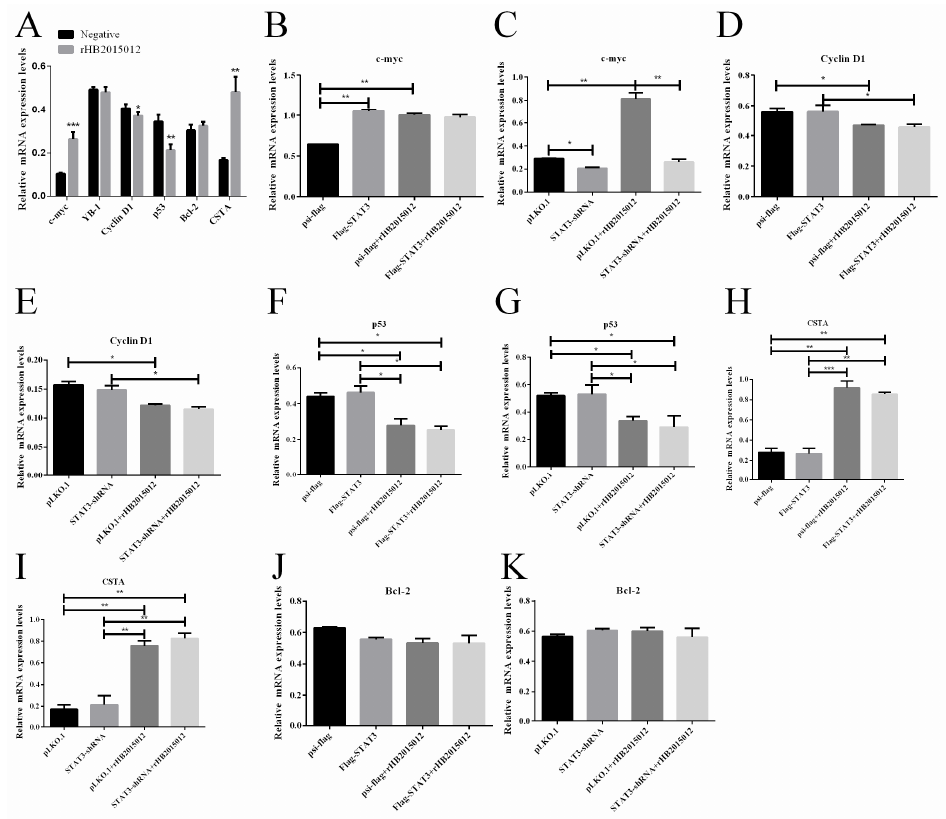
Figure 5. Excessive transcription of c-myc regulated by STAT3 after ALV-A infection (n = 3 and three tests in total). ( A ) ALV-A promoted c-myc expression, inhibited cyclin D1, and did not affect YB-1 at 48 h of infection. ( B , C ) STAT3 promotes c-myc expression at 48 h of ALV-A infection. ( D , E ) Cyclin D1 expression inhibition at 48 h of ALV-A infection but has nothing to do with STAT3.